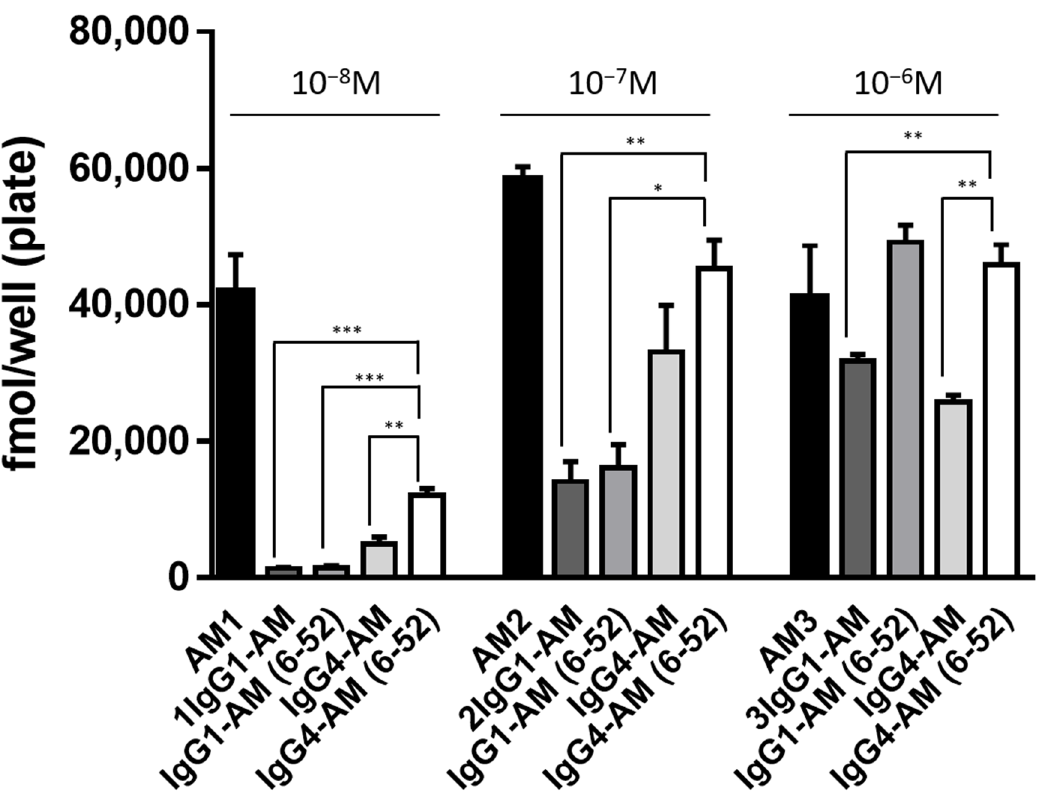
Figure 1. Intracellular cAMP accumulation induced by Fc-fusion proteins. HEK-293 cells stably expressing the AM 1 receptor were incubated with AM or Fc-fusion proteins for 15 min, and the intracellular cAMP levels were measured with an enzyme immunoassay. The data were compared at concentrations of 10 − 8 M, 10 − 7 M, and 10 − 6 M, respectively. The experiments were repeated twice independently, and results are shown as means ± SD. * p < 0.05, ** p < 0.01, and *** p < 0.001 vs. IgG4-AM